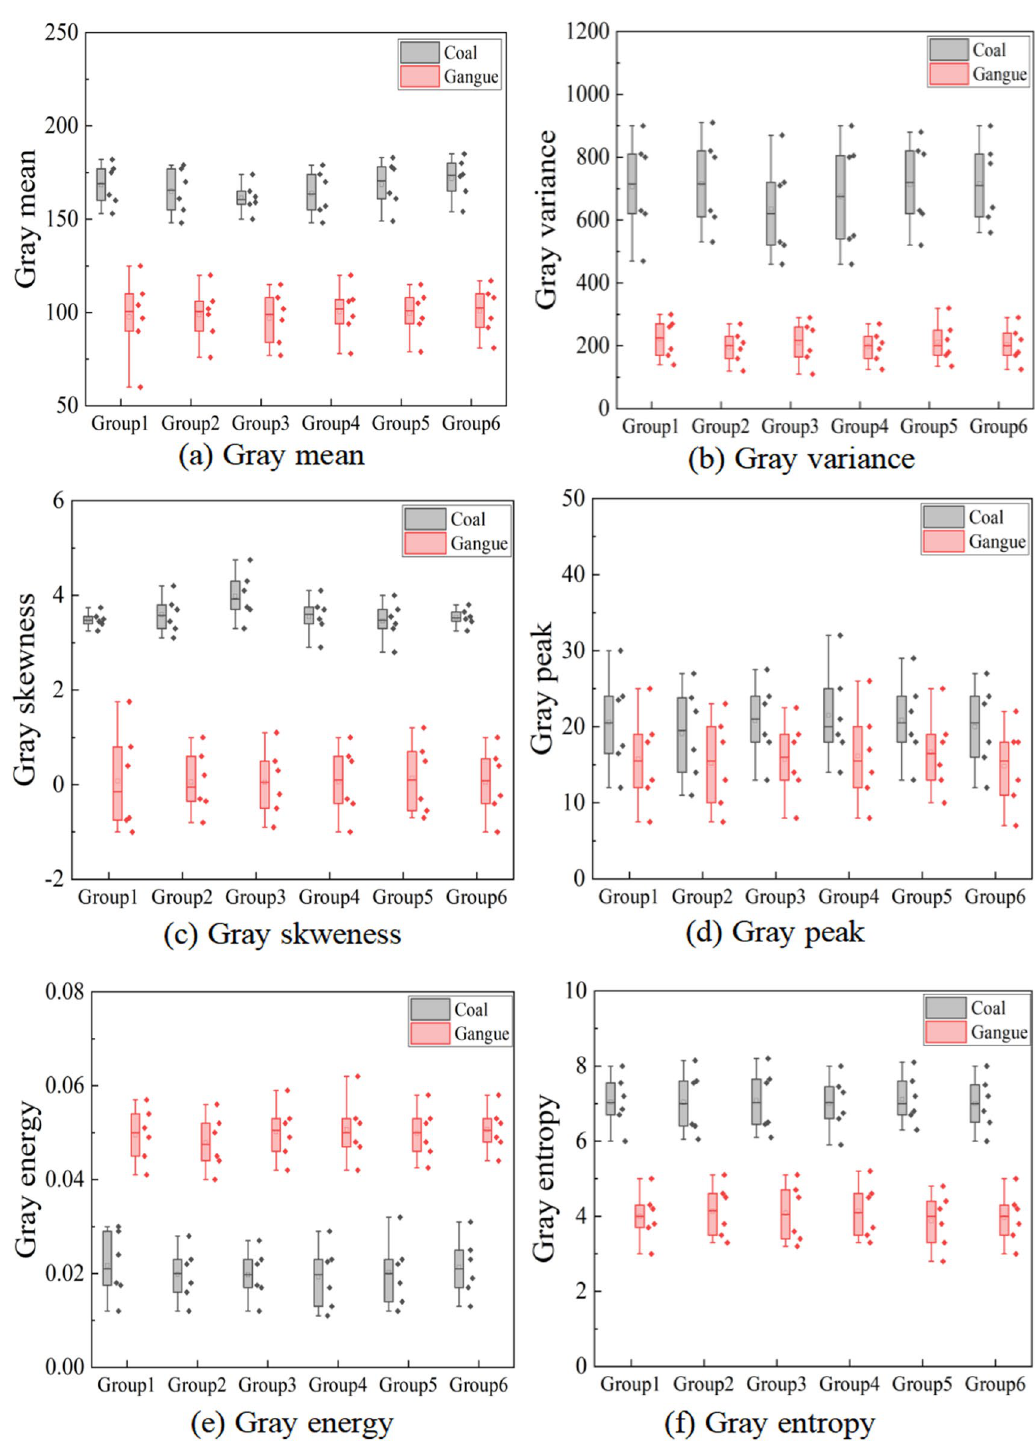
Figure 9. Gray characteristic values of coal and